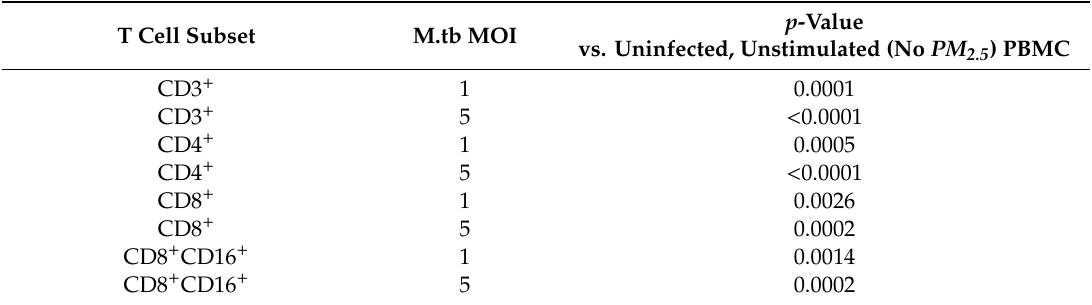
Table 1. Increases in IFN- γ expression levels in T-cell subsets of PBMC infected with M.tb MOI 1 and MOI 5 compared to uninfected and unstimulated (no PM ) PBMC.